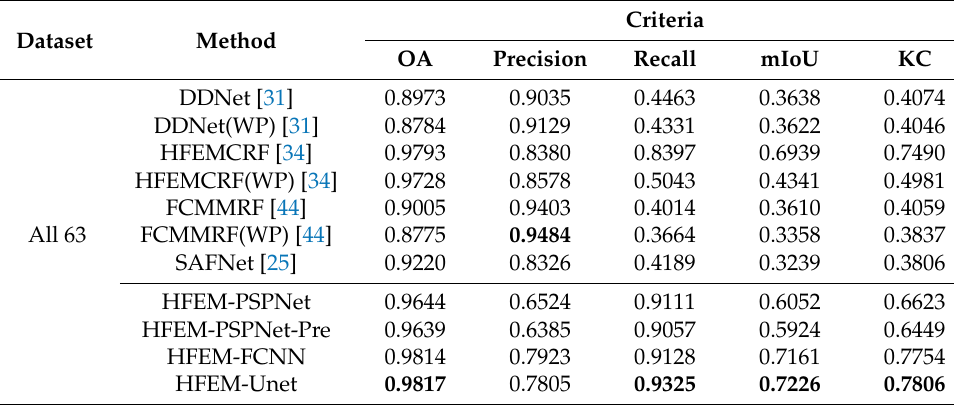
Table 5. The average numerical results of all 63